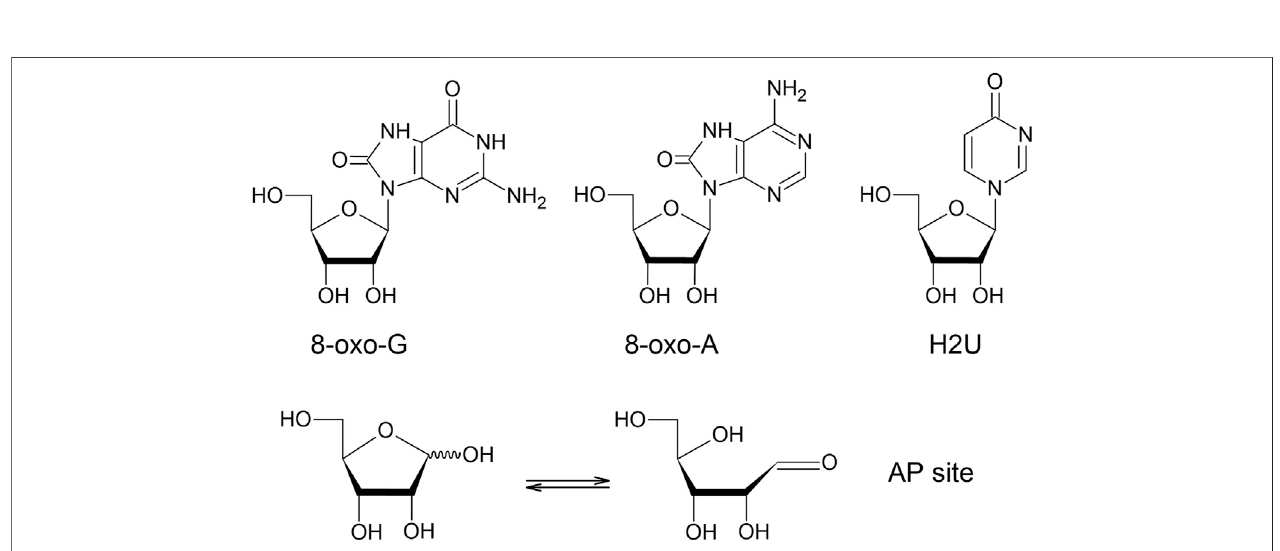
FIGURE2| Chemicalstructuresoftherepresentativeoxidativederivatives.8-oxo-G(8-oxo-7,8-dihydro-guanosine),8-oxo-A(8-oxo-7,8-dihydro-adenosine),H2U (4-pyrimidinone ribofuranoside), and AP site (apurinic/apyrimidinic site). AP site is tautomerized to give rise to two forms.